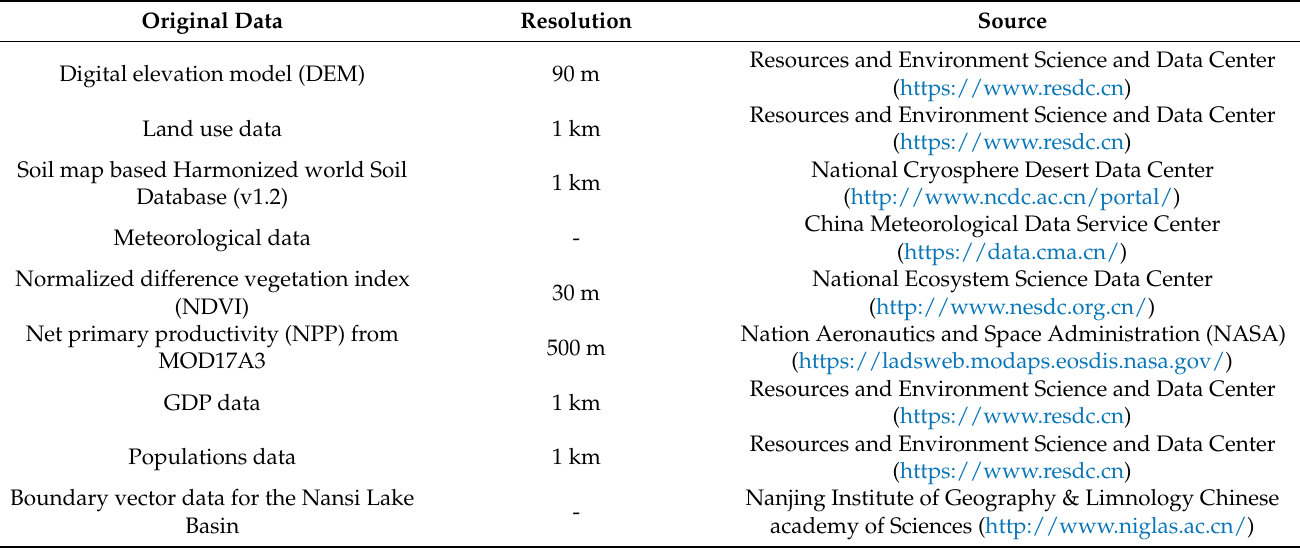
Table 1. The data used in this study and their